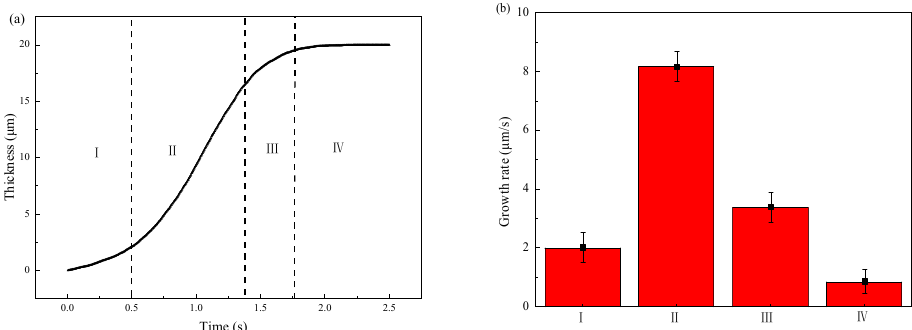
Figure 14. Variations of the IMCs thickness with the simulation time: ( a ) IMCs growth curve and different stages of I–IV, ( b ) growth rate at different stages.